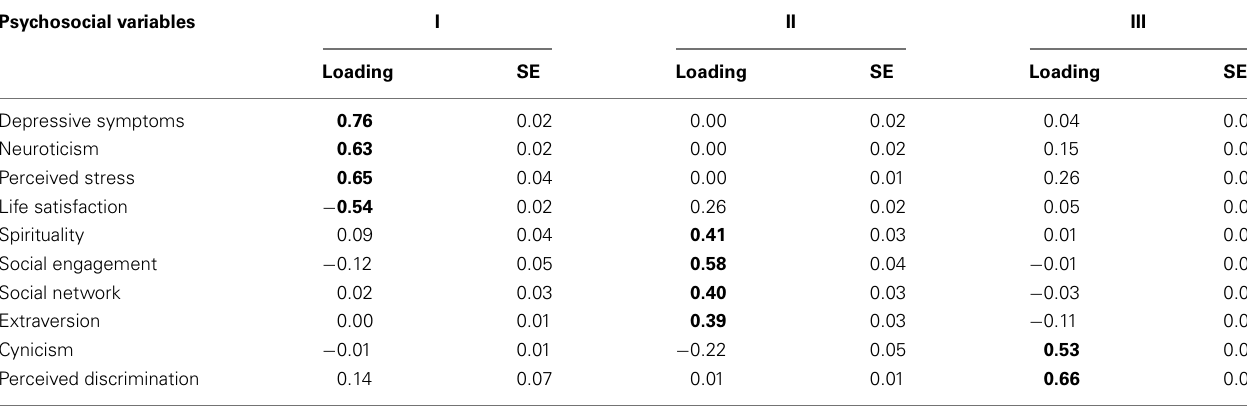
Table 3 | Factor loadings for the three factor model ( N =